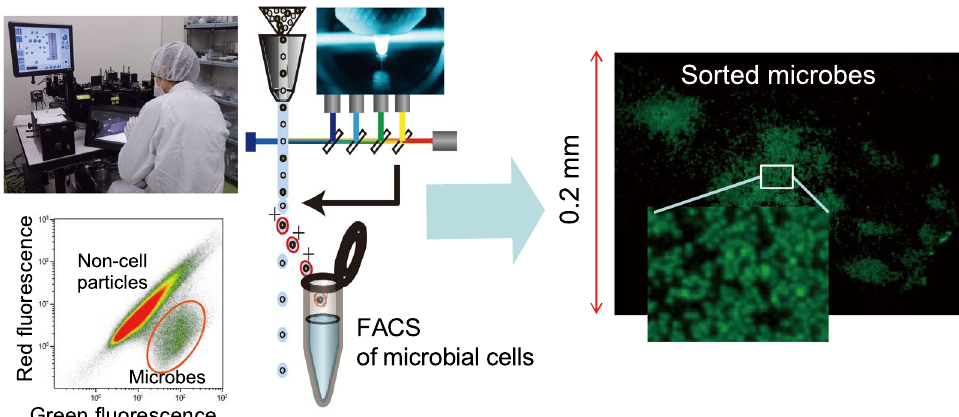
Fig. 5 Scheme of microbial cells purification for NanoSIMS analyses. Density-separated samples were applied to cell sorter after staining with SYBR-I (green). Then, the microbial cells (green) were specifically sorted onto polycarbonate membrane. The speed of sorting ranges few to hundreds of cells per second depending on the cell abundance in the original samples. Modified from Morono et al.